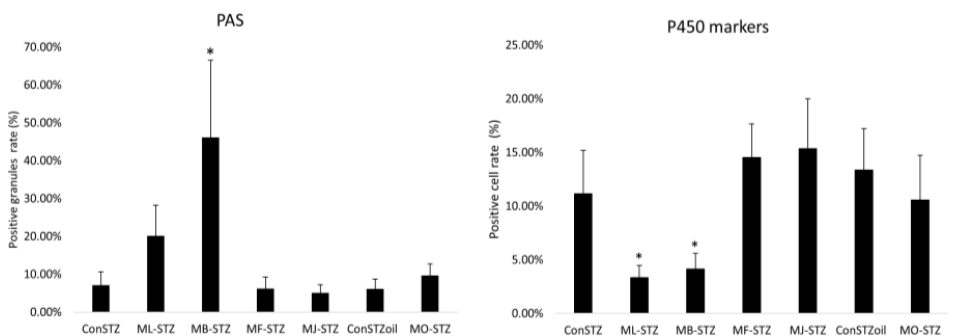
Figure 9. Quantitative (PAS and P450 markers) histopathology analysis of the effects of black mulberry extracts in streptozotocin-induced liver injury. (* p < 0.001 vs. ConSTZ).